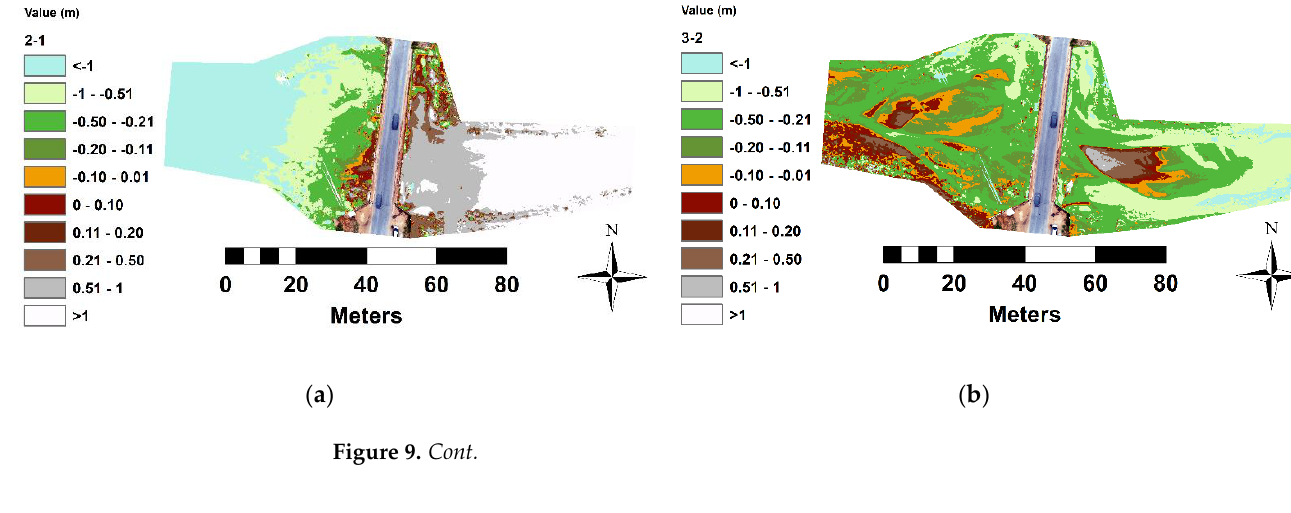
( f ) Figure 9. The produced DoDs extracted when comparing the DSMs for different flights: ( a ) 2 – 5 Jan- uary 2021 with 1 – 24 September 2020, ( b ) 3 – 11 January 2021 with 2 – 5 January 2021, ( c ) 4 – 18 March 2021 with 3 – 11 January 2021, ( d ) 5 – 18 June 2022 = with 4 – 18 March 2021, ( e ) 6 – 24 August 2022 with 5 – 18 June 2022 and ( f ) 6 – 24 August 2022 with 1 – 24 September 2020.